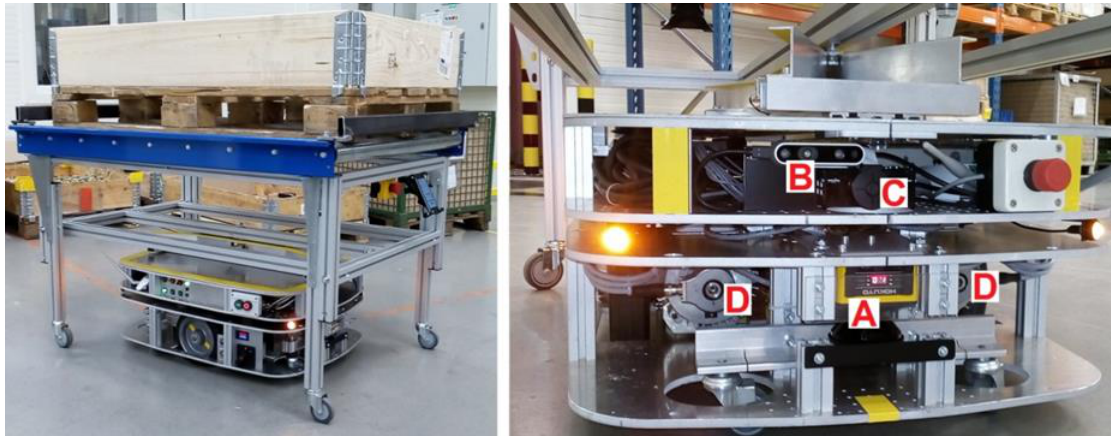
Figure 4. The prototype of autonomous mobile robot under the transport trolley ( left ). Main sensors of the robot ( right ): A—safety laser scanner, B—stereo vision 3D camera, C—high definition 2D camera, D—motor incremental encoders.